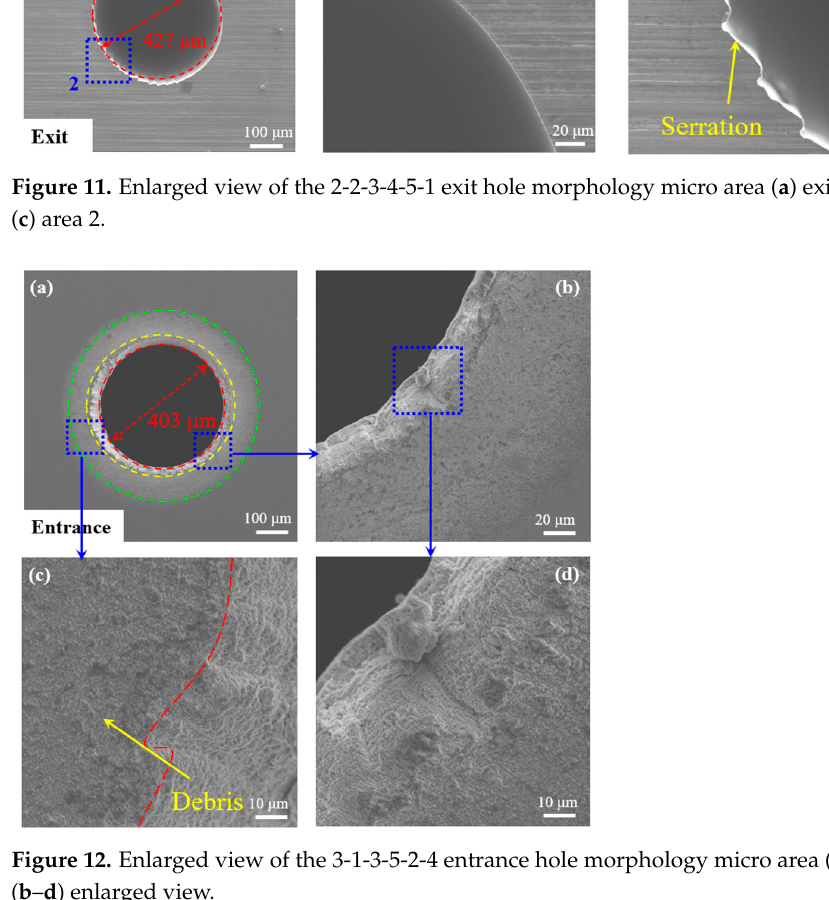
Figure 13. Enlarged view of the 3-1-3-5-2-4 exit hole morphology micro area ( a ) exit hole; ( b ) area 1; ( c ) Area 2. 4.2. Single-Factor Influence Law Analysis Table 6 shows the analytical calculation results data, which can be derived from the DD6 single crystal high-temperature alloy hole size as well as the extreme difference dis- tribution of taper. Figure 14 shows the influence pattern of different parameters on the DD6 single crystal high-temperature alloy. M i is considered as the average of all experimental data under this parameter and R is the range. The relationship between R and M i is R = Max (M i ) − Min (M i )